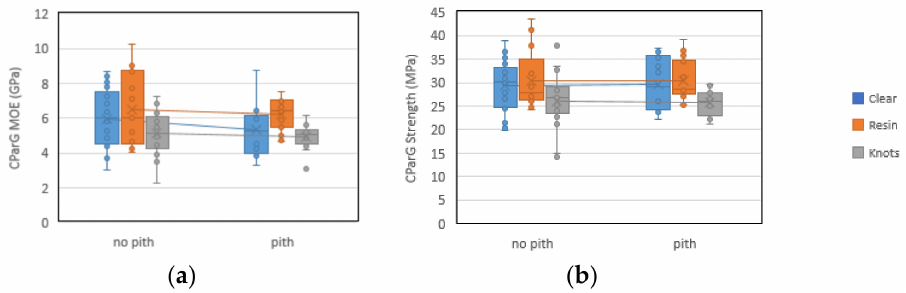
Figure 16. Box plots of CParG properties with and without pith—( a ) MOE and ( b ) strength.